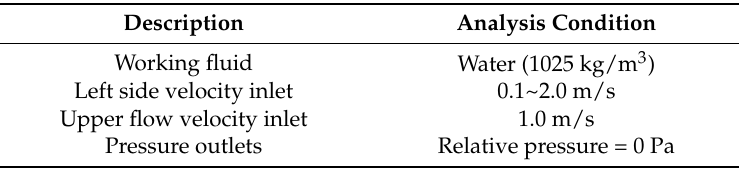
Figure 6. ( a ) Comparison of the Cp vs. λ response of the experimental results of [26,27] and the simulation results of [25]; ( b ) comparison of the Cd vs. λ response of the experimental results of [26,27] and the simulation results of [25].